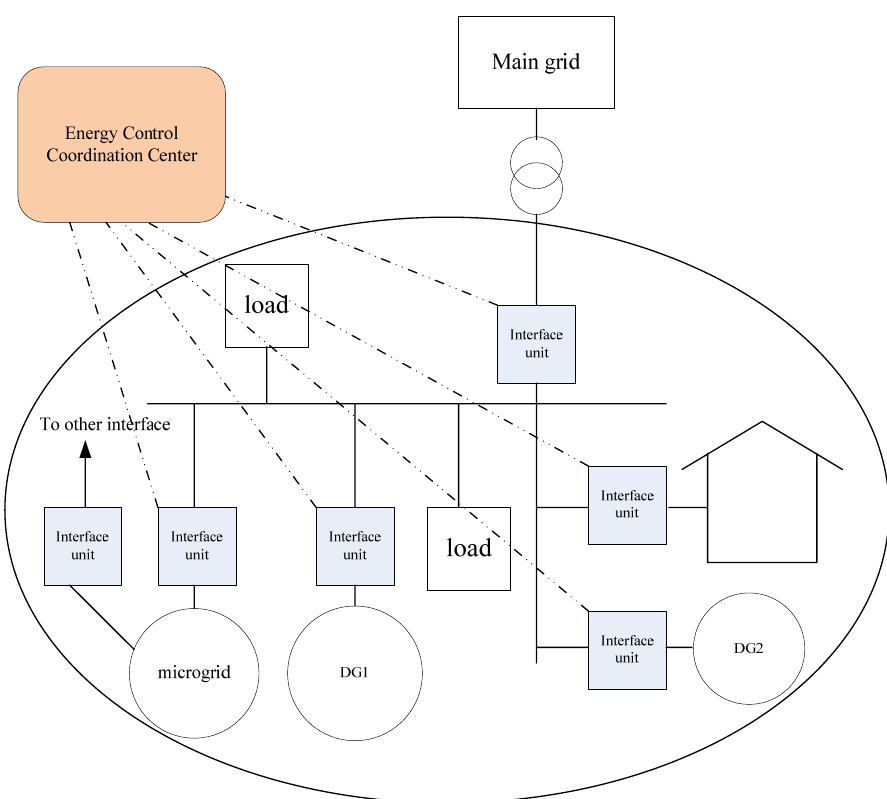
Figure 1. The coordination model in